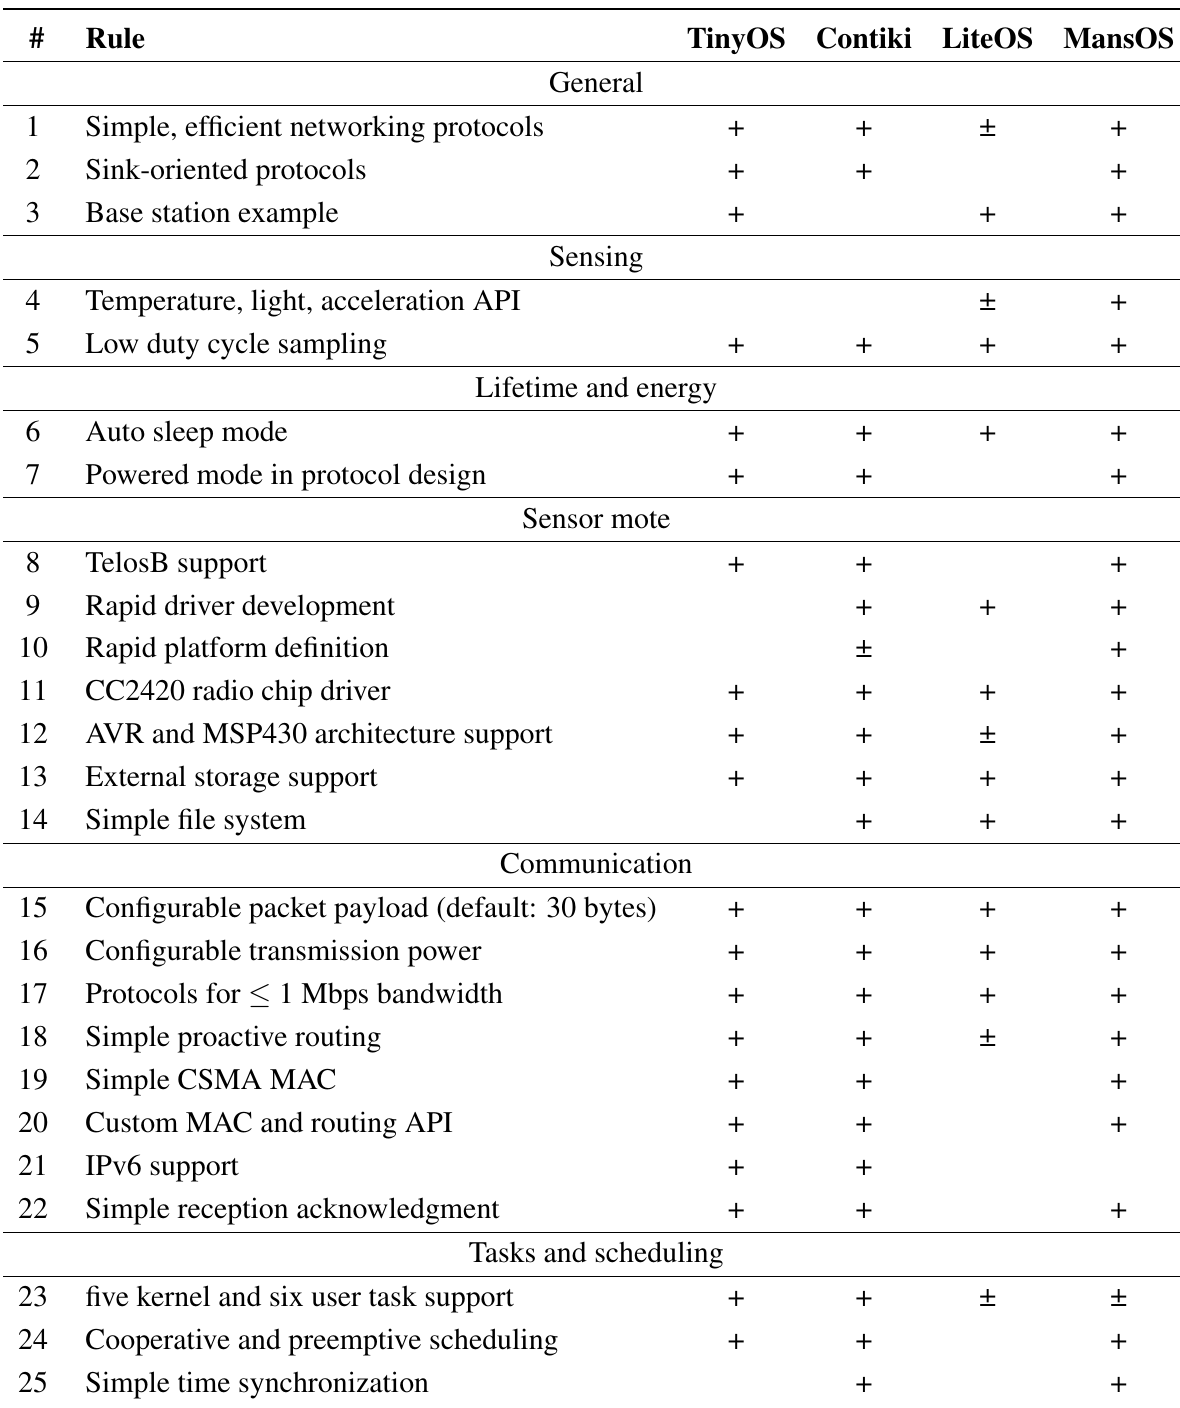
Table 18. Existing OS conformance to proposed design